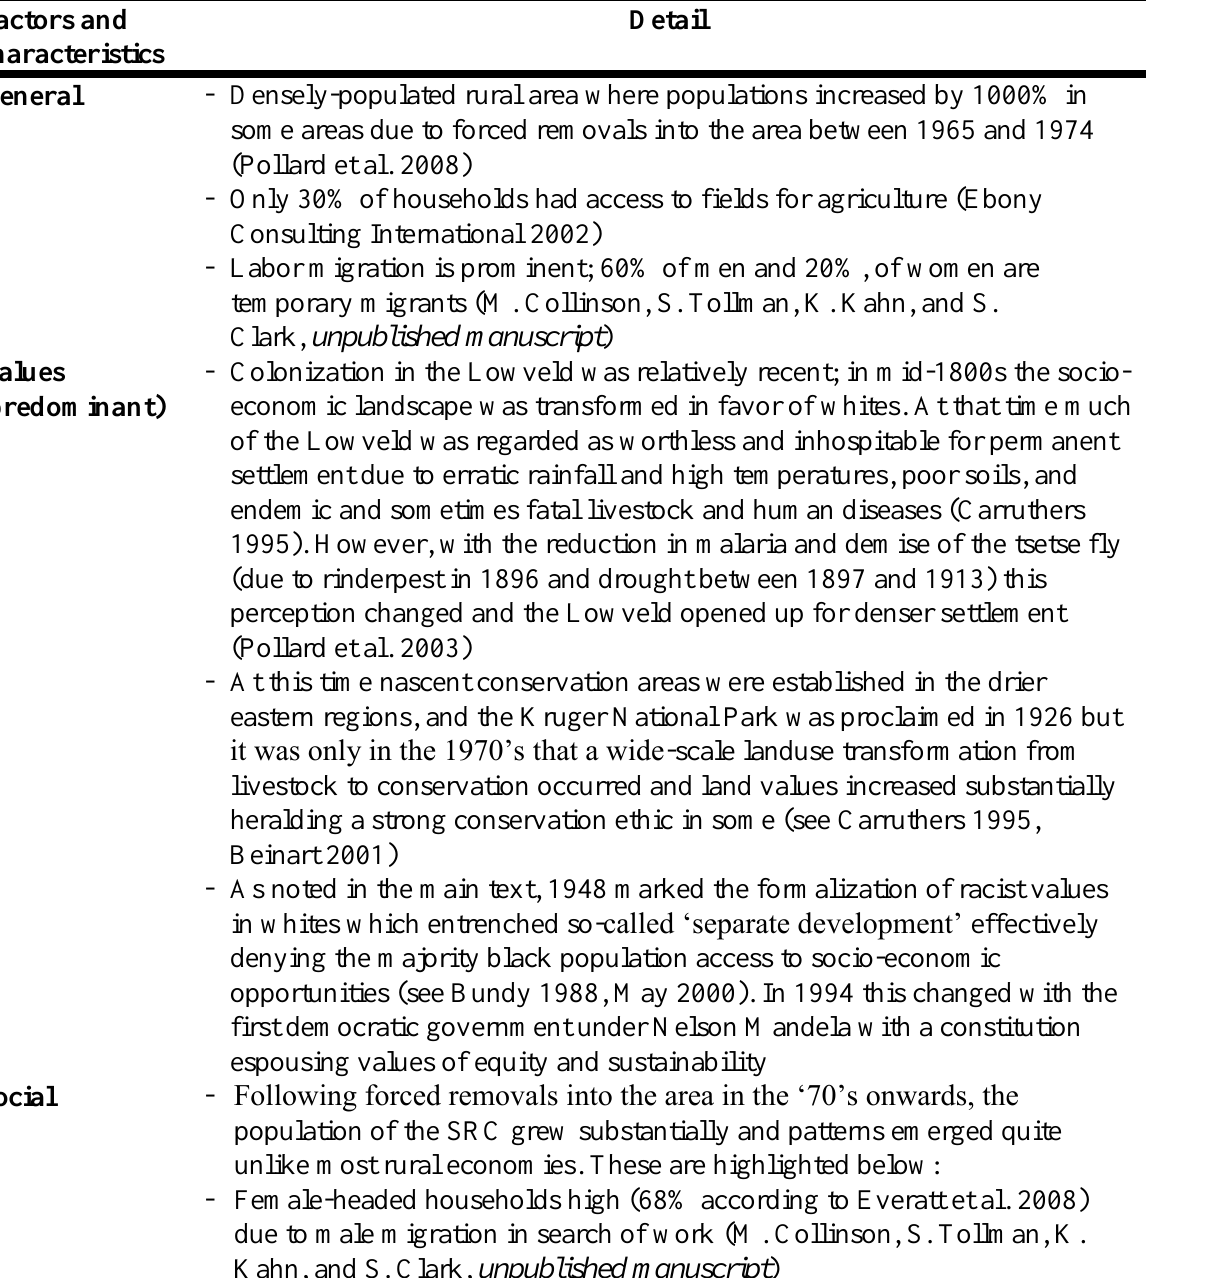
Table A3.1. An example of the contextual scoping of Zone B based on a V-STEEP description of the Sand River